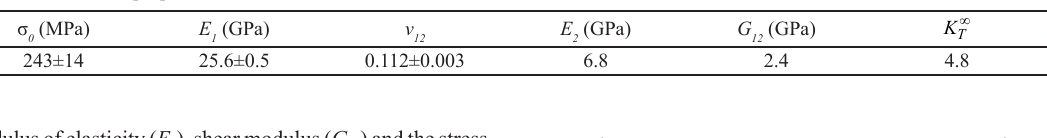
Figure 2. Four-point bending test in the sandwich laminate. Table 2. Mechanical properties of the sandwich